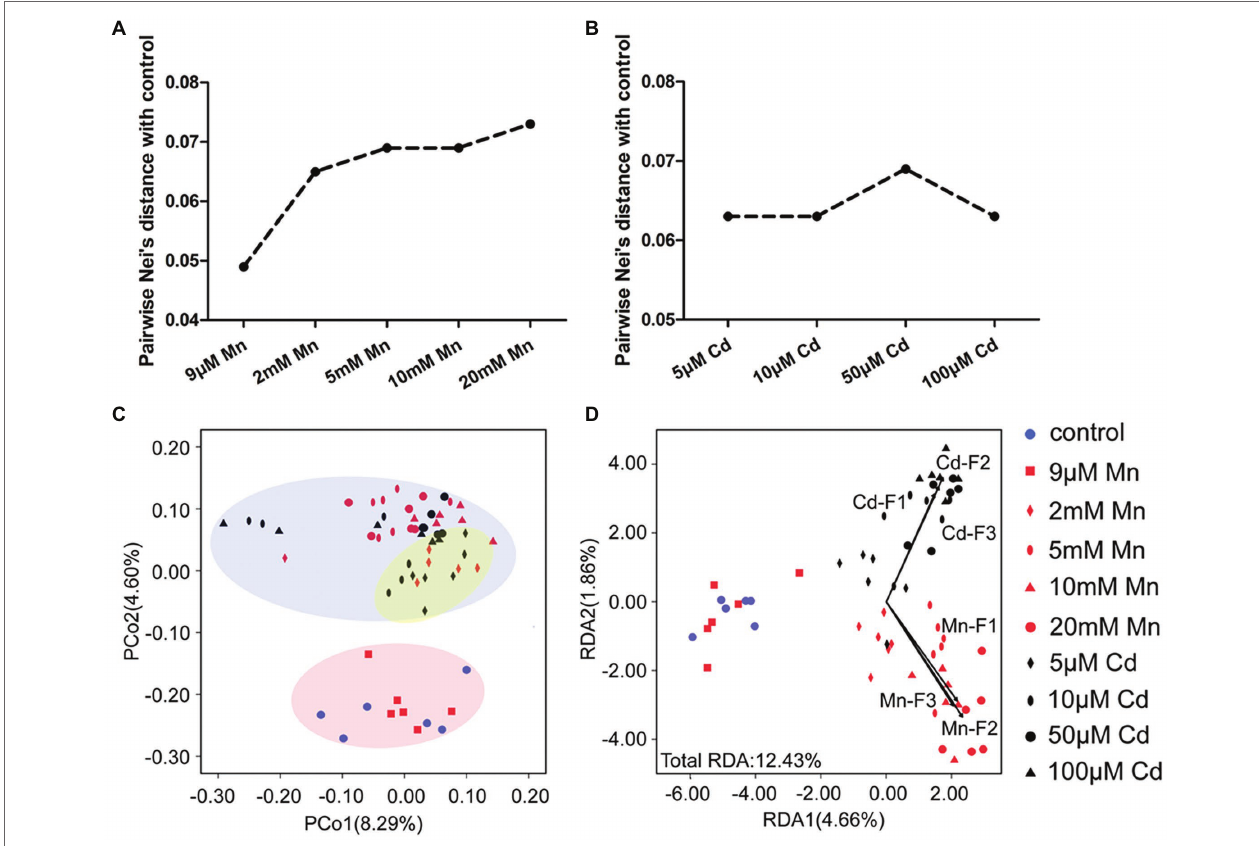
FIGURE 5 | DNA methylation analysis based on MSAP profiling of pokeweed under a series of Mn or Cd treatments. (A,B) MSAP-based Nei’s distances between the control group and (A) Mn treatments and (B) Cd treatments. (C) Principal coordinates analysis (PCoA) of changes in DNA methylation in seedlings subjected to 20 days treatment of Mn and Cd. (D) Redundancy analyses (RDA) of changes in DNA methylation changes using Mn and Cd concentrations in cell walls (F1), organelles (F2), and the soluble fraction (F3) as explanatory variables under different